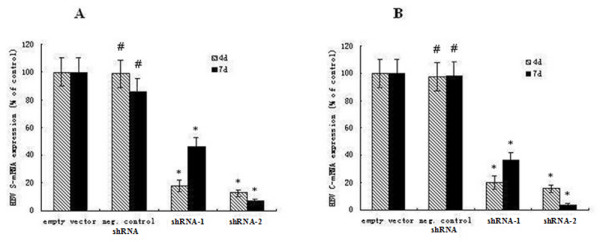
The inhibitory effects on HBV RNA levels by transfection with HBV ShRNAs. NOD SCID mice were cotransfected with 12 μg pTHBV2 and 1.6-2.0 ml pWPT-HBV- ShRNA-1, 2 or negative control shRNA. The mice were sacrificed 4 d and 7 d after cotransfection, and hepatocytes RNA was extracted. Each experiment was carried out in triplicate. (A) The total levels of HBV S-mRNA in NOD SCID mouse livers were significantly reduced on day 4 or 7 after treatment with pWPT- HBV-shRNA-1 and shRNA-2 lentivirus. (B) The total levels of HBV C-mRNA were significantly decreased on day 4 or 7 after treatment with pWPT-HBV-shRNAs in mice. (error bars indicate standard errors). The values shown were the average of three experiments (means standard deviation). The mean value of empty control was defined as 100%. * P < 0.05 vs. the empty vector group. # P > 0.05 vs. the empty vector group.